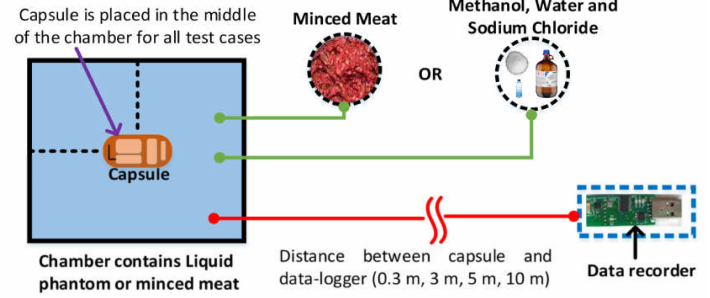
Figure 11. Experimental setup for testing transmission rate of the proposed prototype. A plastic storage box is used as a test